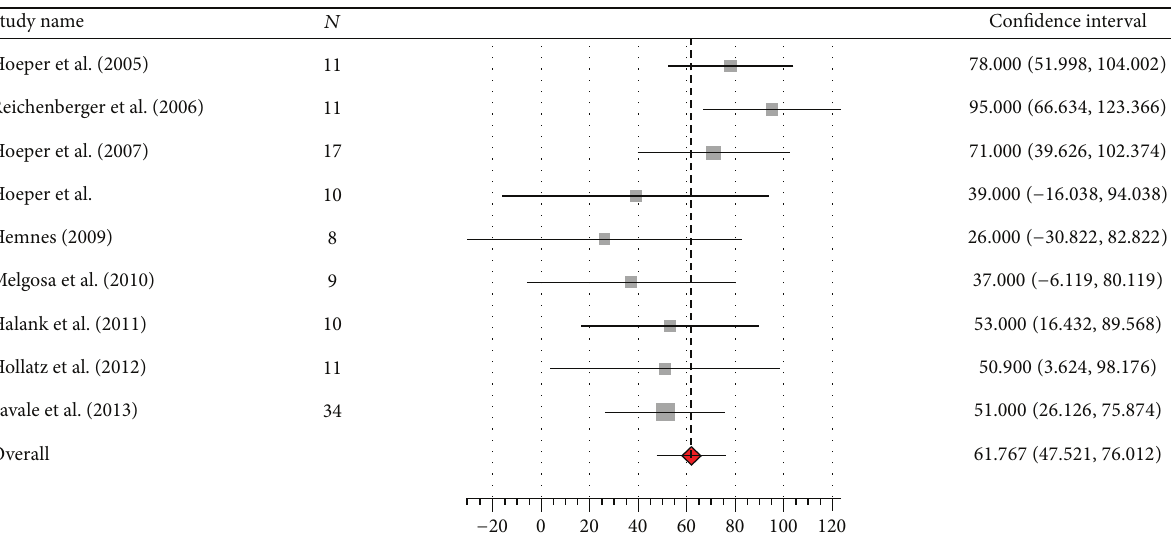
Figure 5: Effect of PAH specific therapy on 6-minute walk distance